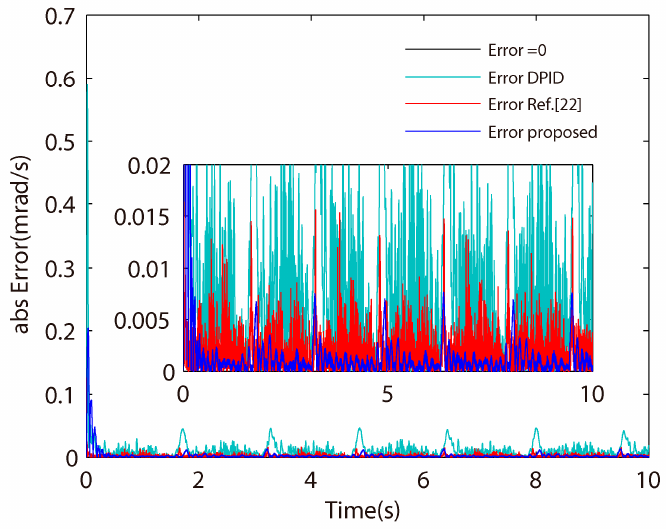
Figure 13. Absolute value of sinusoidal guidance error curve.